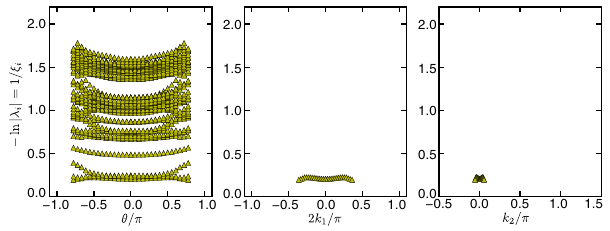
FIG. 17. The transfer matrix spectrum of a magnetic order. Here, we show a YC8-2 cylinder, with J 2 ¼ 0 . 3 , and the bond dimension m ¼ 2000 .